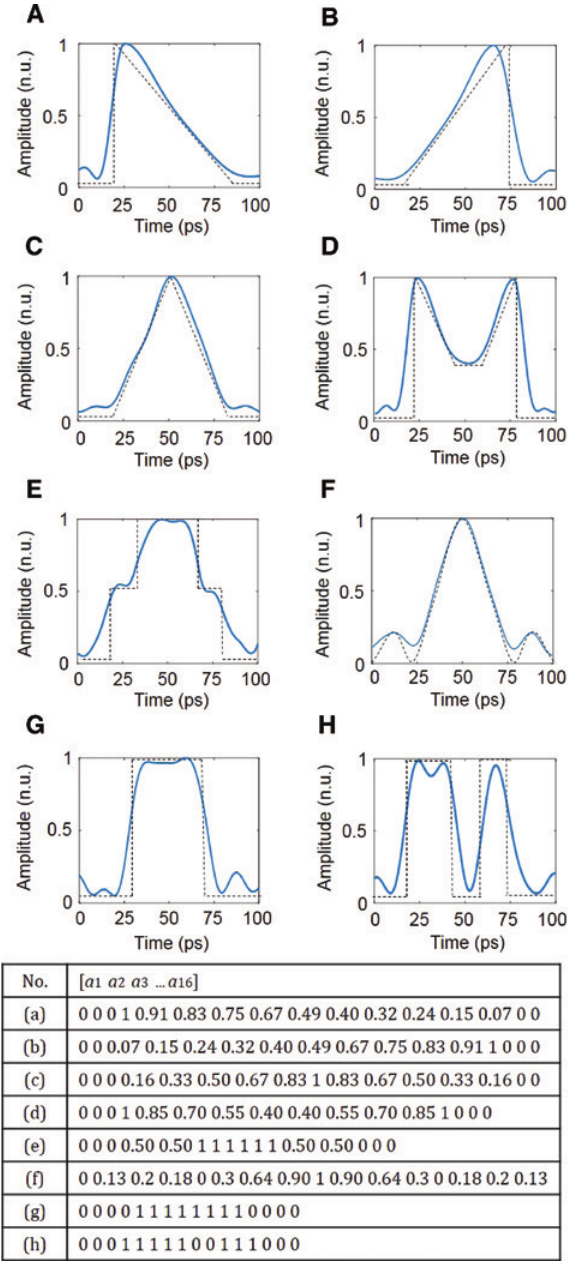
Figure 8: Measured waveforms (blue solid line, the waveforms are normalized to the peak intensity) from the filter: (A) falling ramp; (B) rising ramp; (C) triangular waveform; (D) waveform having ramps and steps; (E) waveform having both climbing and falling steps; (F) sinc-function waveform; (G) square waveform and (H) binary bit pattern waveform. The black dashed lines outline the envelopes of the ideal waveforms. Inset table: filter